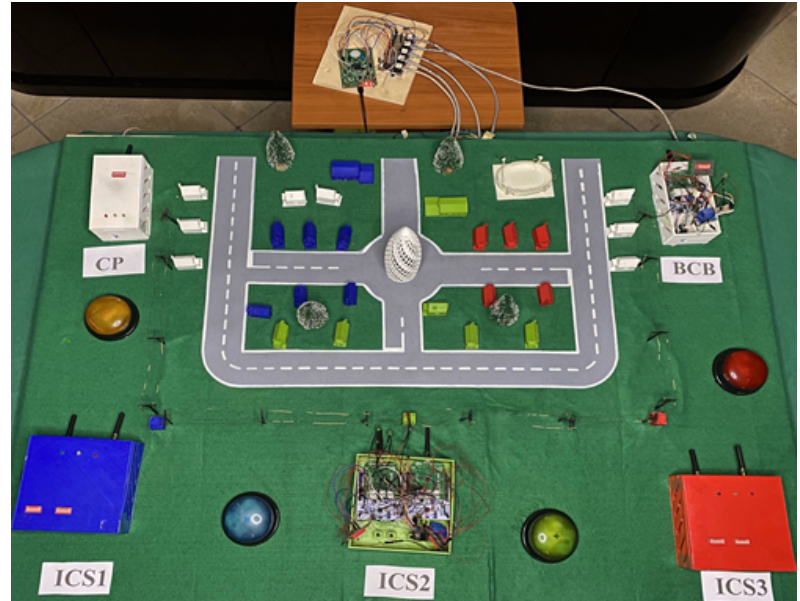
Figure 2. Demonstrator developed for laboratory